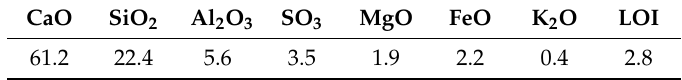
Table 2. Chemical Composition (wt %) of Portland cement, ordinary type P.O. 42.5.